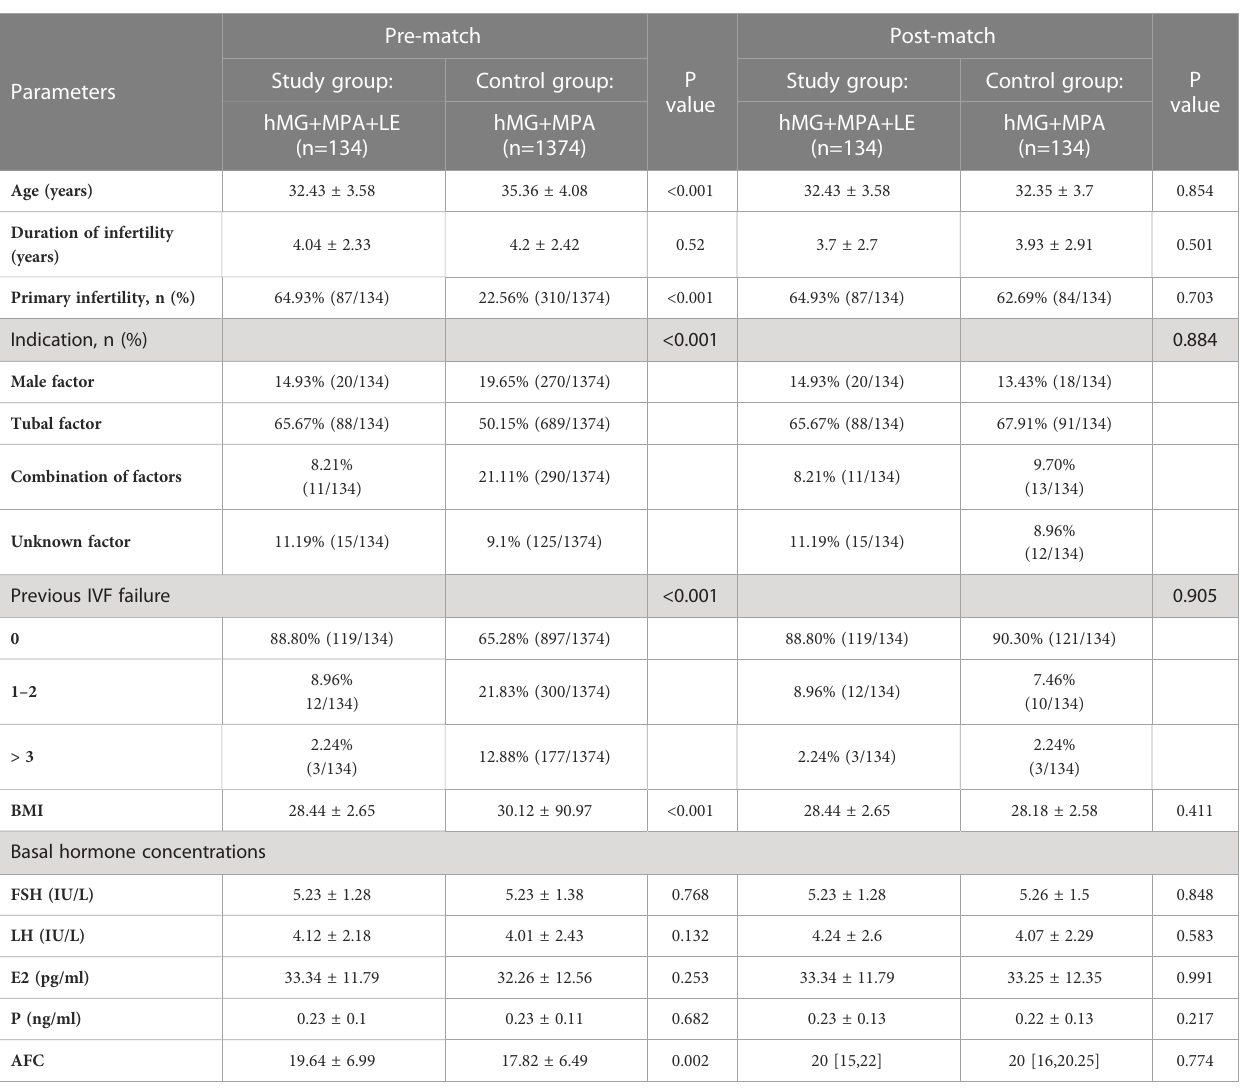
TABLE 1 The baseline parameters of the two groups before and after